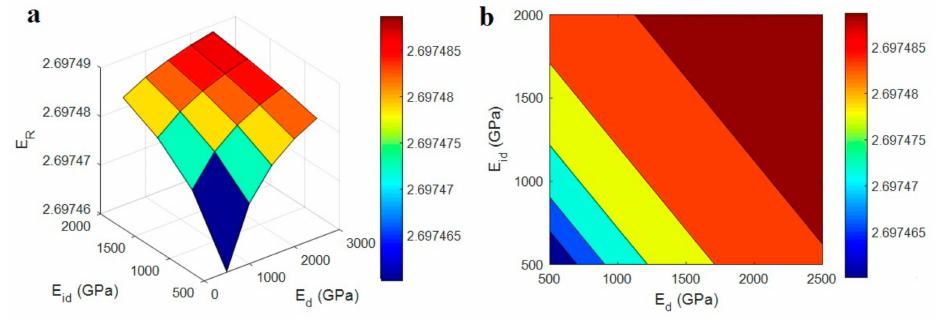
Figure 1. The influences of “ E d ” and “ E id ” parameters on the predicted modulus (Equation (10)): ( a ) 3D and ( b ) contour